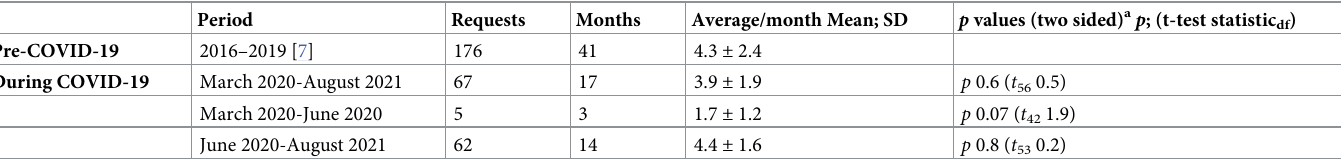
Table 2. FMT requests for rCDI during versus before the COVID-19 pandemic.